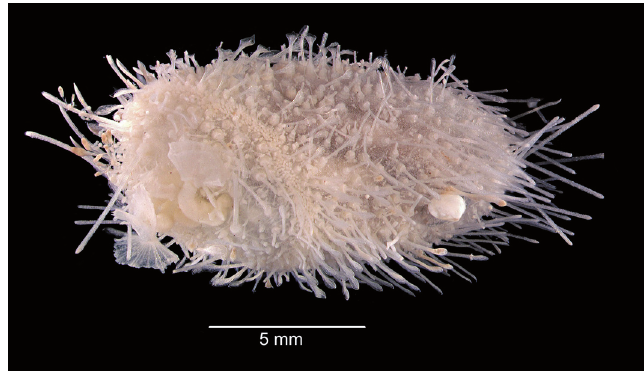
Fig. 5. Aeropsis rostrata (Wyville Thomson, 1877) with Kelliola symmetros (Jeffreys, 1876) attached, from Biscay.